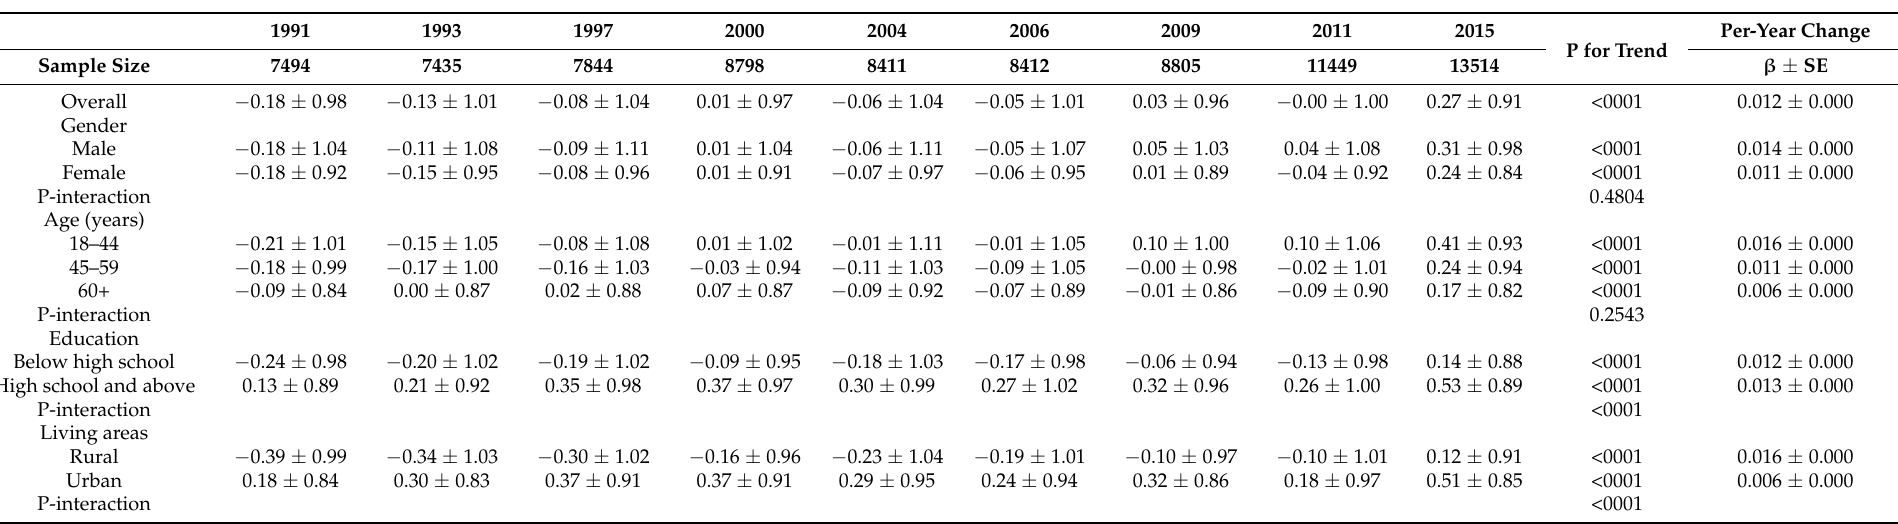
Table 5. Trends for the meat pattern score among Chinese adults from 1991 to